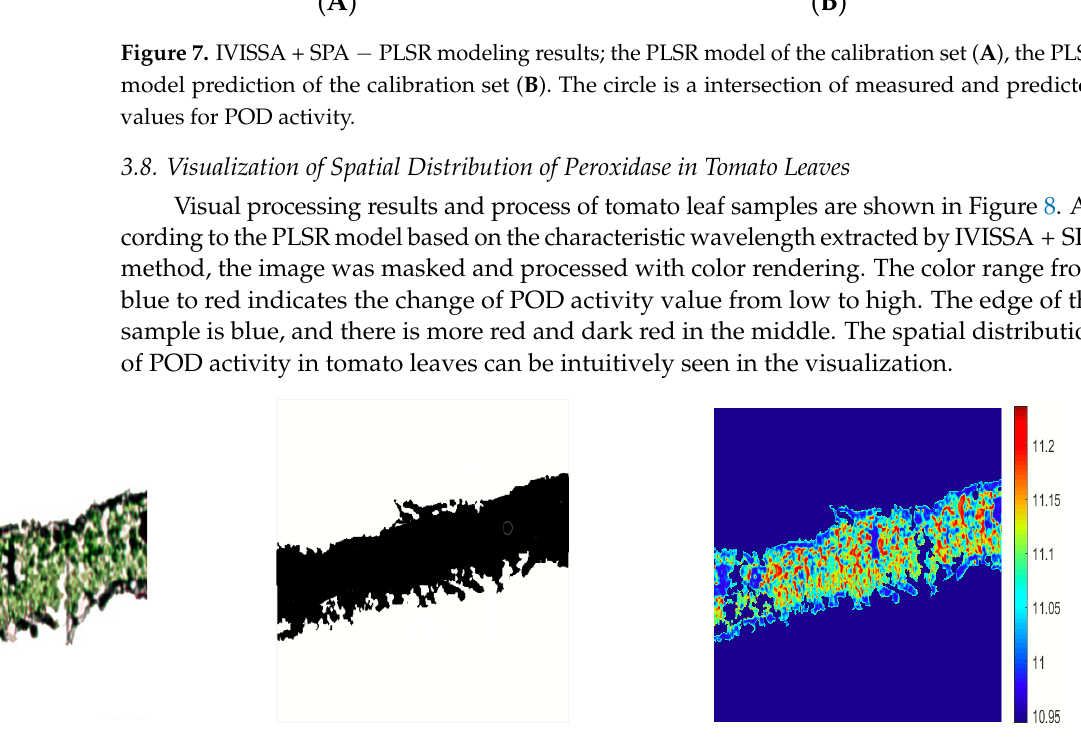
Figure 8. Spatial distribution visualization of POD activity in tomato leaves based on PLSR model.